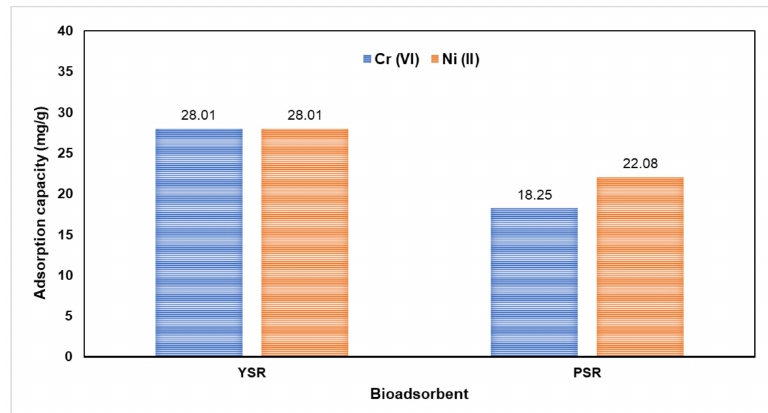
Figure 6. Experimental packed-bed column capacity. n =